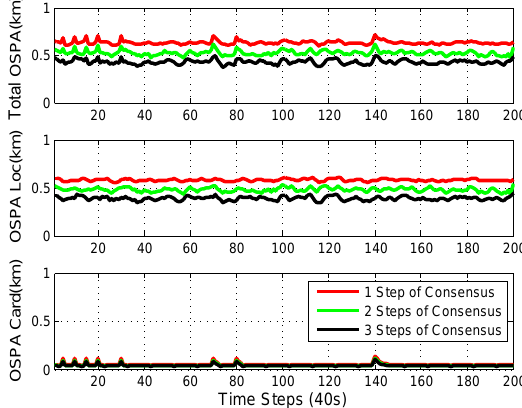
Figure 9. OSPA performance with different consensus steps. More consensus steps yielded better performance.